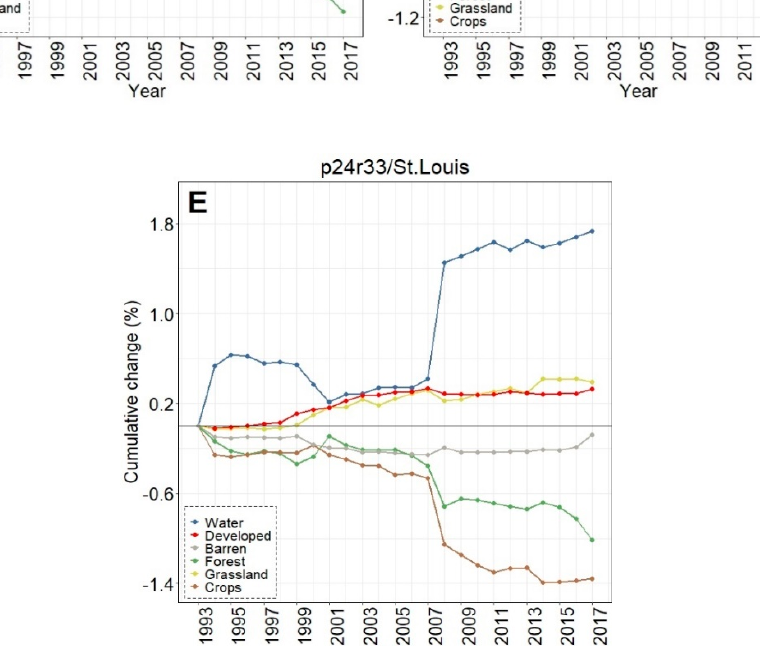
Figure 15. St. Louis footprint LULC change over time in surface-water buffers binned into five aquatic system size, ( A ) < 0.1 ha, ( B ) 0.1 to < 1.0 ha, ( C ) 1.0 to < 10.0 ha, ( D ) 10.0 to < 100.0 ha, ( E ) ≥ 100.0 ha. Note the differences in the Y-values between plots.